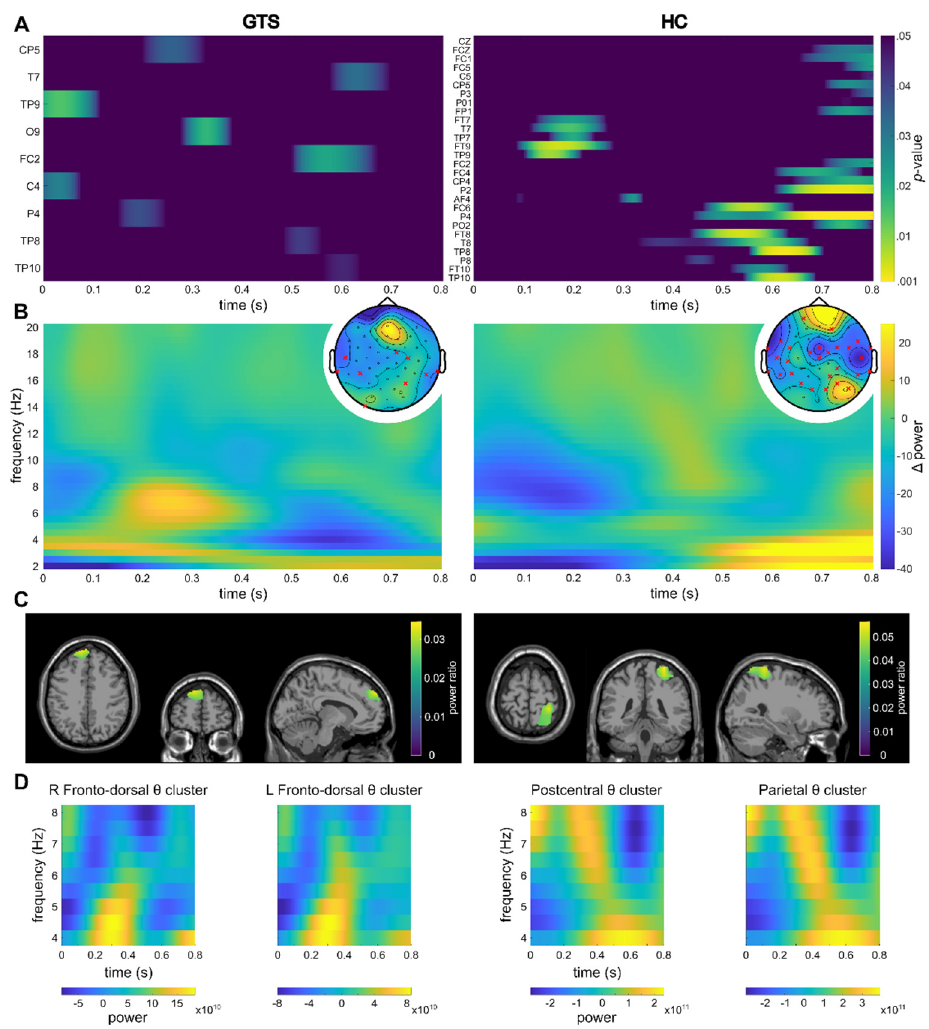
Figure 2. Within-trial results. For all subplots, the left side of the figure refers to the GTS group, whereas the right side refers to the HC group. ( A ) Significant channels and timeframes for channel- wise t-tests on theta power between the feature overlap and no-feature overlap conditions are shown. Warmer colors indicate smaller p -values (colormap threshold at p < 0.05). ( B ) Sensor-level time frequency representation of the difference between the feature overlap and no-feature overlap conditions over the channels showing significant differences in the theta band are shown (please refer to 2A). Topoplots show the mean theta power over the entire segment as well as the significant channels (indicated by a red cross). ( C ) Clusters as identified by the DBSCAN algorithm are shown. The identified clusters (refer to Section 3) are visualized on a template MRI. For voxels within the cluster, the source ratio (difference between the feature overlap levels divided by the sum of the overlap levels) is visualized. ( D ) Time-frequency representations of the theta band in in the respec- tive clusters.